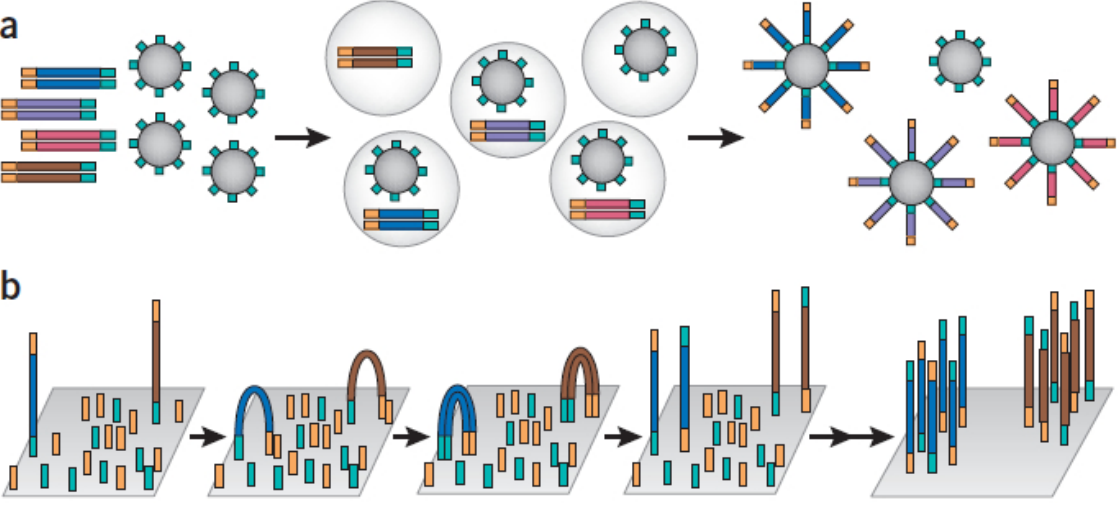
Figure 4. Two clonal amplification methods used in MPS. ( a ) Emulsion PCR used by Roche 454 and IonTorrent MPS platforms. Enriched DNA products with attached adaptors (yellow and turquoise adaptors flanking the DNA sequences) are combined with beads that have one of the PCR primers tethered to its surface. The PCR amplification takes place in a water-in-oil emulsion vesicle with only one template present in each compartment. The amplicons are captured on the surface of the bead. Once amplification is complete, the emulsion compartments are broken, and the amplified products will be selectively enriched; ( b ) The Illumina platform uses the bridge PCR to clonally amplify its products. Enriched DNA products with attached adaptors (yellow and turquoise adaptors flanking the DNA sequences) are placed on a chip that is densely coated with both adaptor primers tethered to a solid surface. As PCR takes place, amplicons from a given template will remain tethered close to the point of origin. When the PCR is complete, each clonal cluster contains ~1,000 copies of a single template. The image is reproduced with permission from